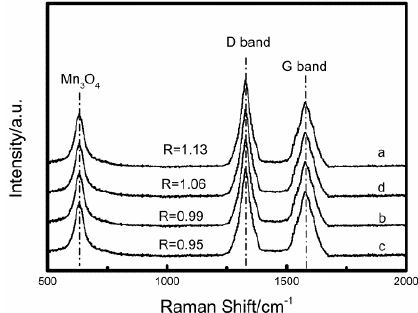
Figure 3. Raman spectra of ( a ) Mn 3 O 4 /CNTs-1 CNTs ( b ) Mn 3 O 4 /CNTs-2 ( c ) Mn 3 O 4 /CNTs-3 ( d ) Mn 3 O 4 /CNTs-4.